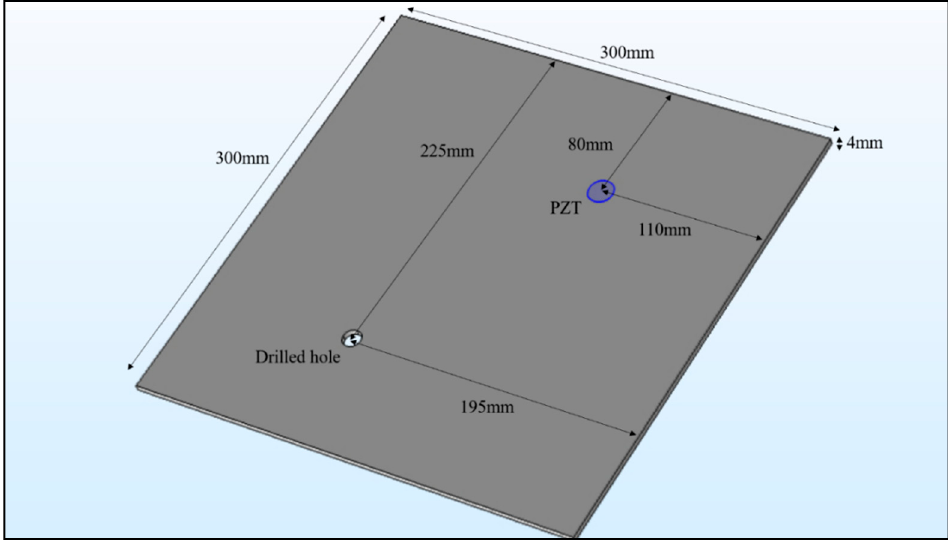
Figure 3. Damaged aluminium plate with a surface bonded piezoelectric (PZT) transducer.